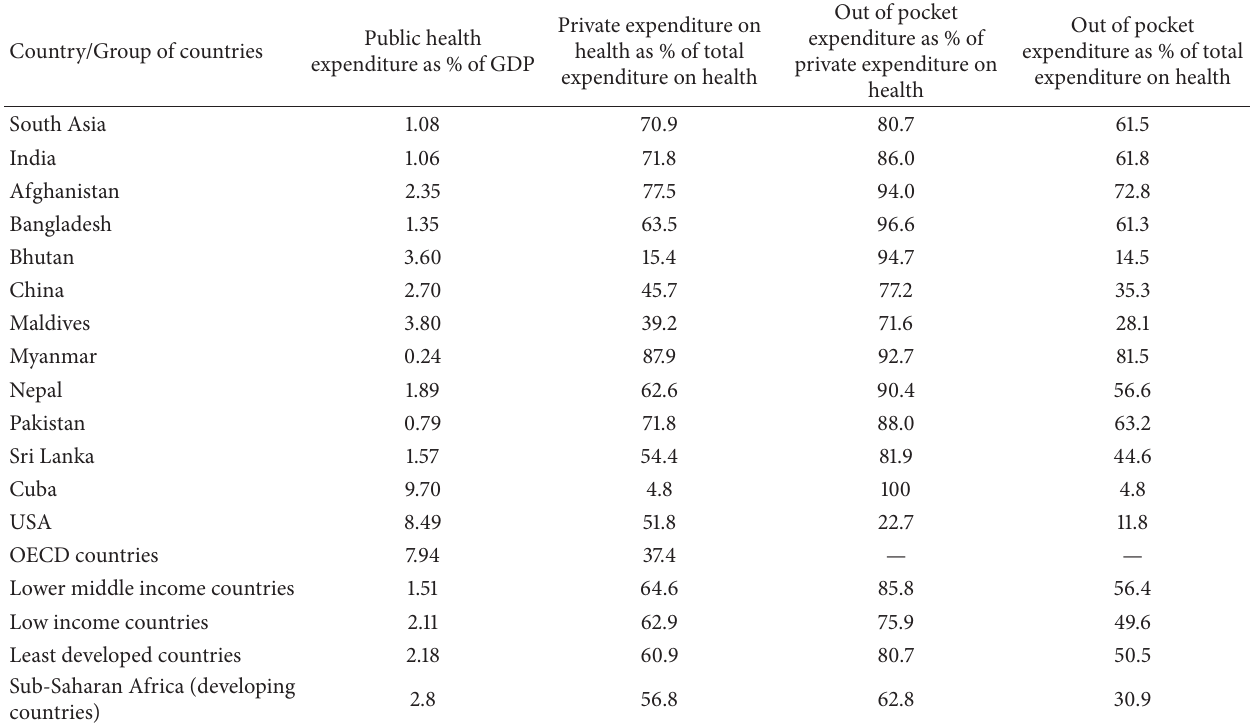
Table 7: Health spending indicators for selected group of countries, India and India’s neighbors, 2010. Public Country/Group of countries